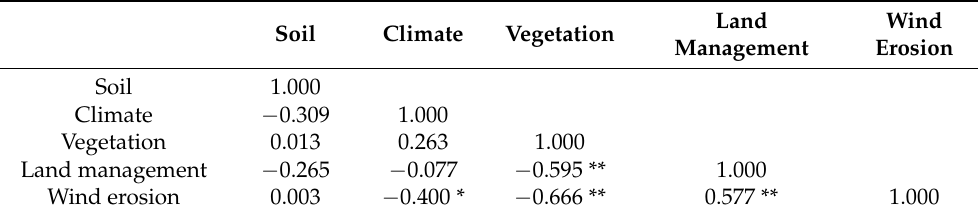
Table 6. Correlation matrix among the five quality